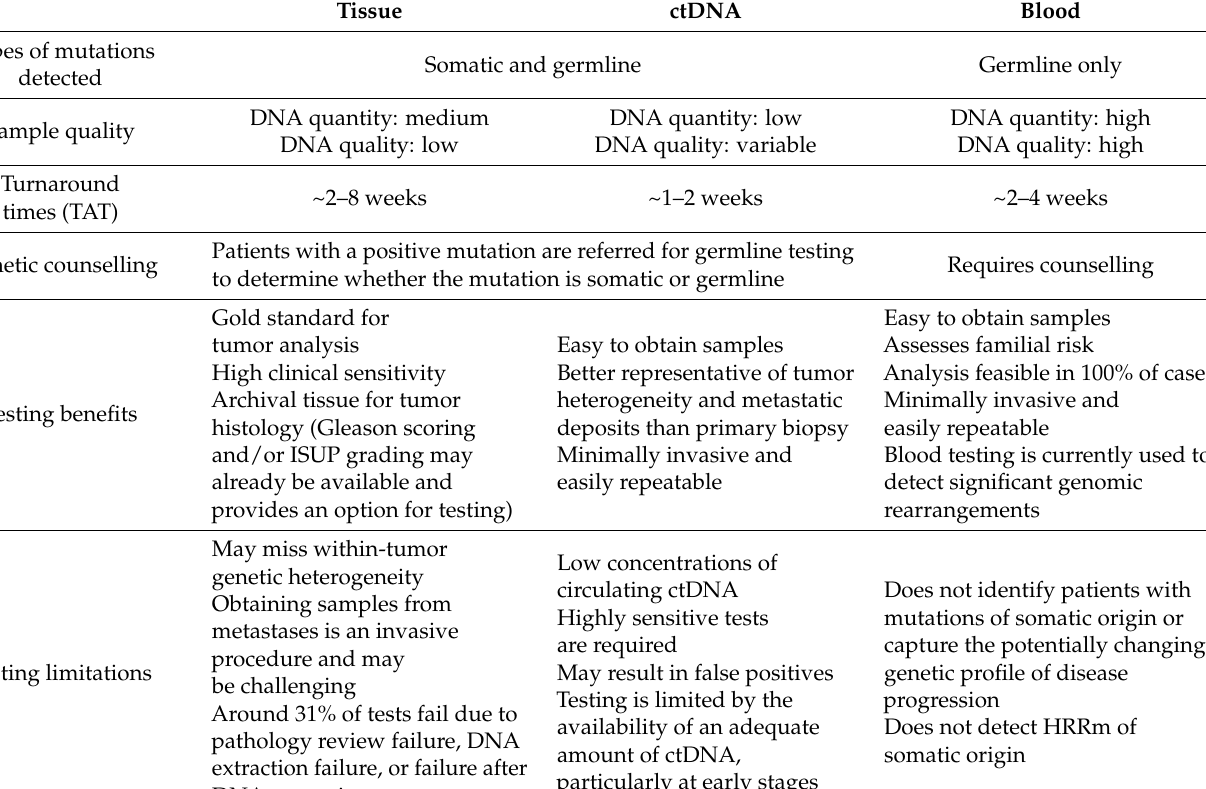
Table 3. Benefits and limitations of tissue, ctDNA, and blood-based HRR gene tests.